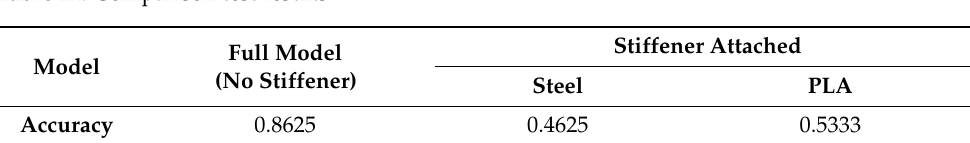
Table 12. Comparison test